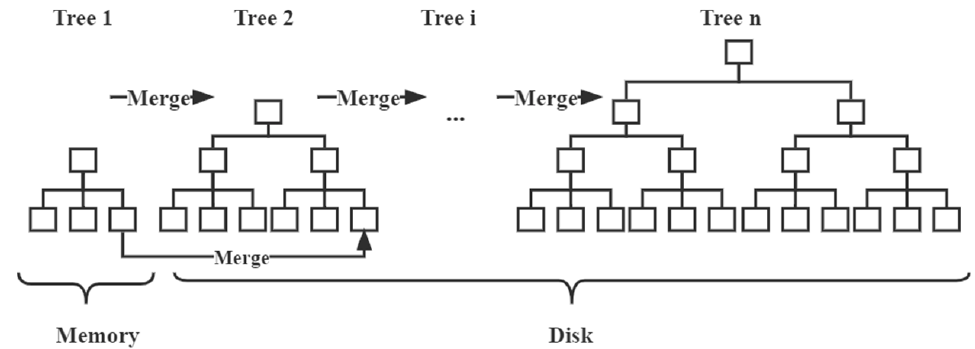
Figure 4. The structure of LSM-Tree.